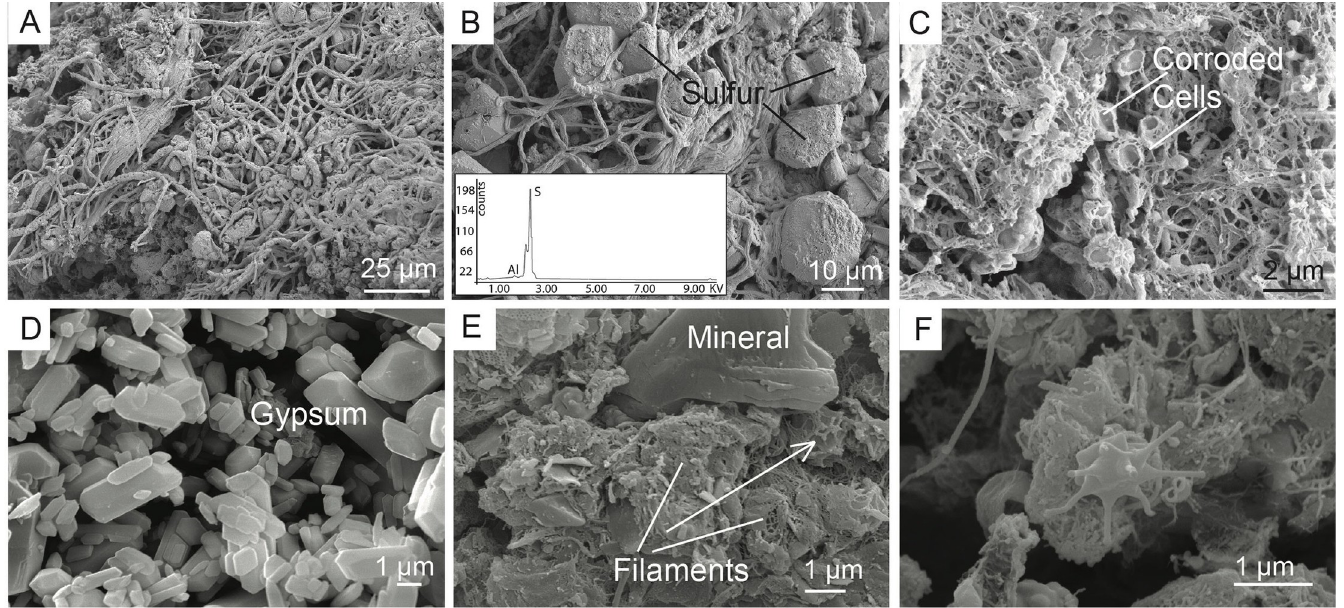
Fig 3. FESEM images of the biodeposits collected in Fetida Cave. A) Elongated filaments and particles characterized by sulfur crystals in F-stream samples; B) EDS spectrum of a sulfur crystal surrounded by filaments; C) F-sed collected from the water stream bed inside the cave. They appear more corroded than F-stream collected at the cave entrance; D) Gypsum microcrystals of moonmilk; E) V-brown is composed of a filamentous network, amorphous matrix and minerals. Minerals can be totally surrounded by filaments (see white arrow), which is probably the result of trapping and binding processes occurring in vermiculations; F) Prosthecate bacterium in grey vermiculation